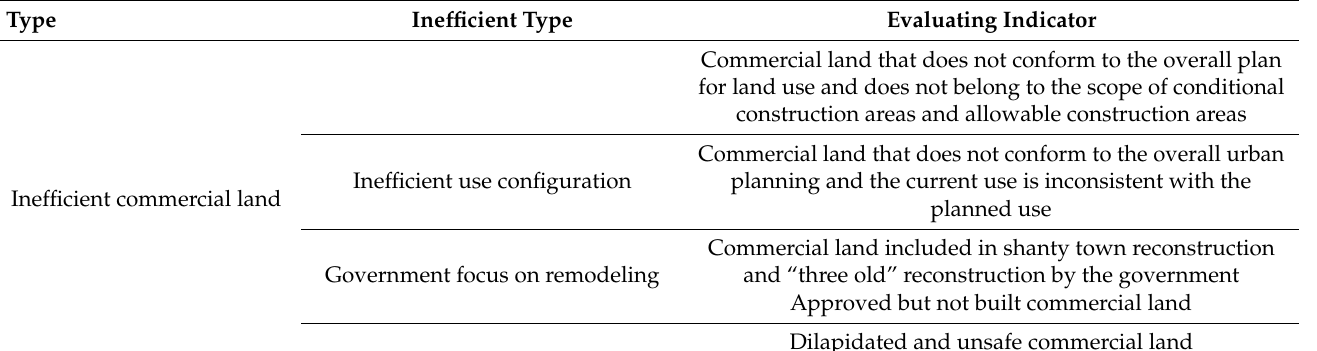
Table 4. Identification standard of low-efficiency commercial